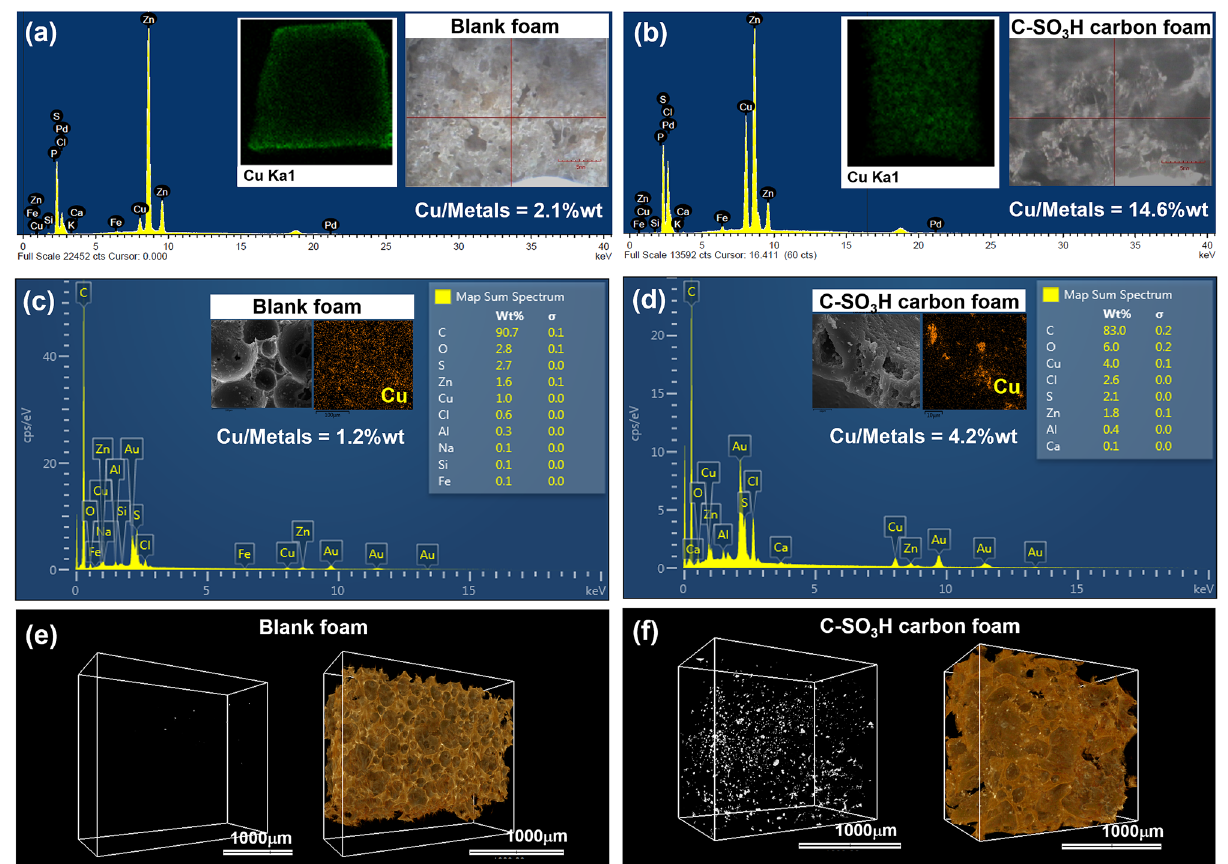
Figure 5. XRF (a,b) SEM–EDX (c,d) and (e,f) tomographic 3D visualisation of blank foam and C-SO 3 H carbon foam after Cu(II) adsorption at 1500 ppm (pH 1) for 200 min.